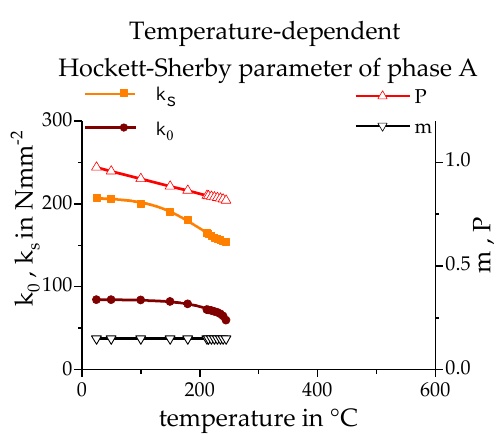
during cooling after a 180 °C maximum temperature (phase A).